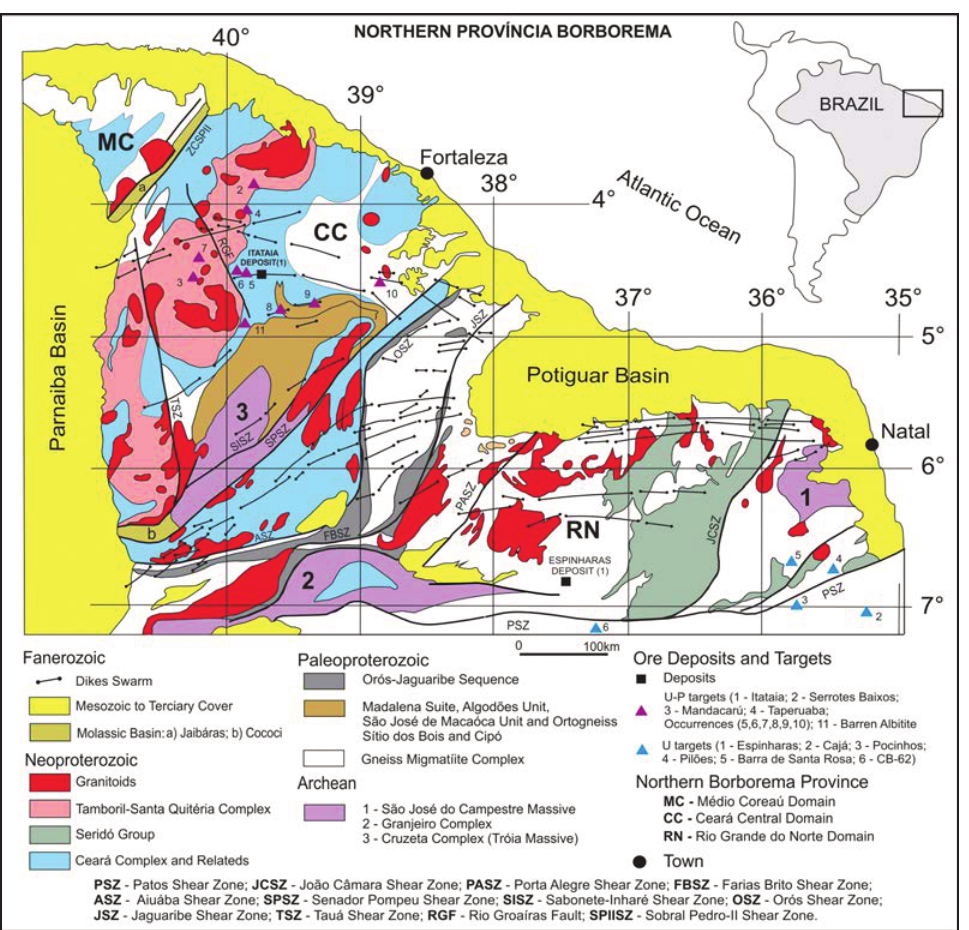
Figure 1 - a) Simplified geological map of Northern Borborema Province with location of Itataia and Espinharas deposits,and targets, and the Ceará-Mirim dikes swarm (modified from Santos and Anacleto 1985; Hollanda et al. 2006; Arthaud et al .